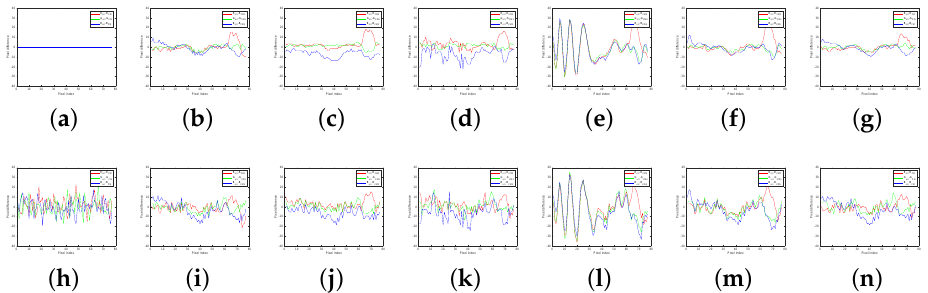
Figure 9. Visual comparison of the color demosaiced image from the noise-free and noisy datasets with σ n = 0.03. The upper parts of each row show the enlarged images, and the lower parts of each row show the difference maps. The first row shows the results of color demoisaicing without noise, and the second row shows noise with σ n = 0.03: ( a ) Ground truth, ( b ) CM1 [10], ( c ) CM2 [27], ( d ) CM3 [28], ( e ) CM4 [13,21], ( f ) CM5 [13], ( g ) PM. ( h – n ) use the same methods as ( a – g ).